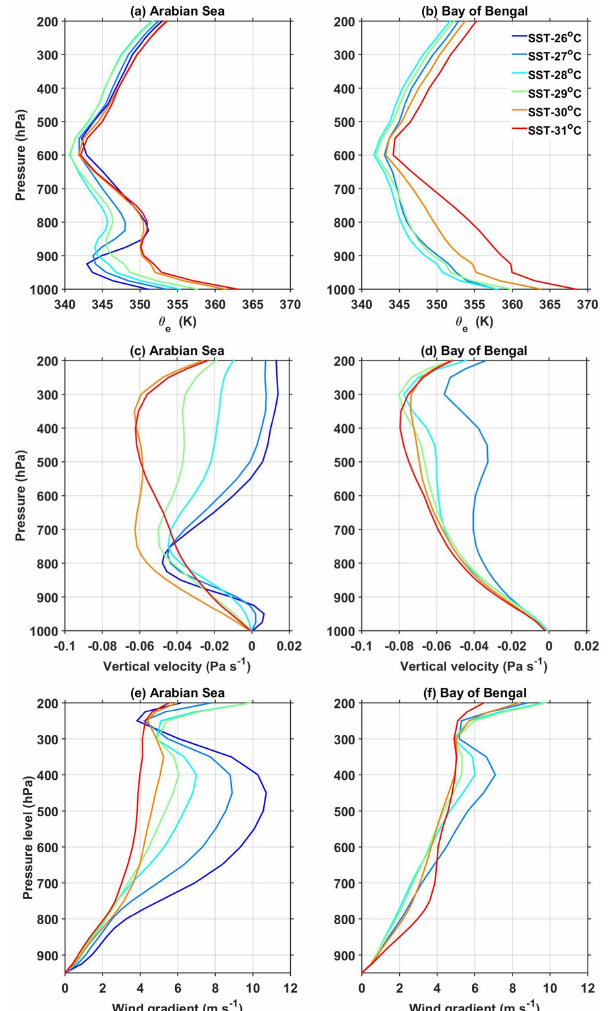
Figure 5. (a) and (b) , respectively, represent the vertical profiles of mean θ e (in K) with SST over the AS and the BOB during the ISM season. (c) and (d) and (e) and (f) are same as (a) and (b) but for mean vertical velocity (in Pas − 1 ) and wind gradient with reference to 950hPa level (in ms − 1 )